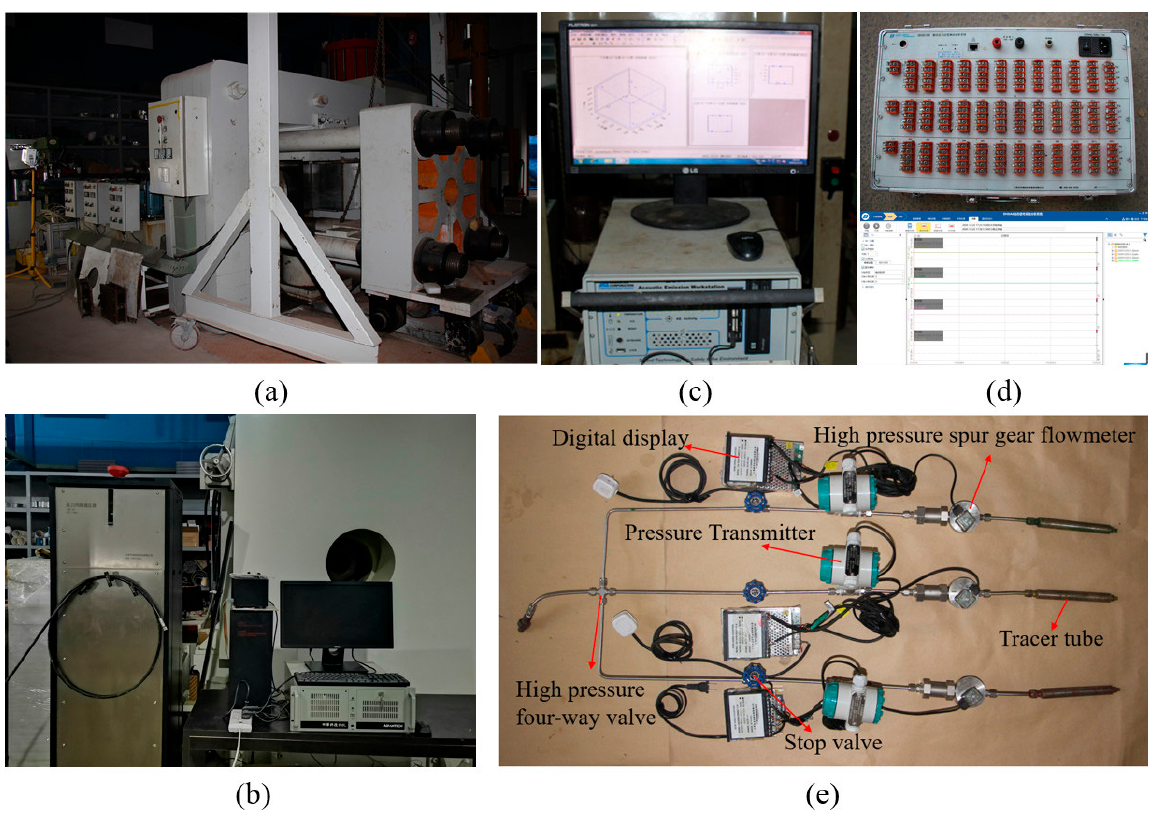
Figure 2. Physical map of experimental equipment: ( a ) large-scale true triaxial testing machine; ( b ) hydraulic fracturing pumping system; ( c ) acoustic emission system; ( d ) strain monitoring system; ( e ) multi-channel shunting system.